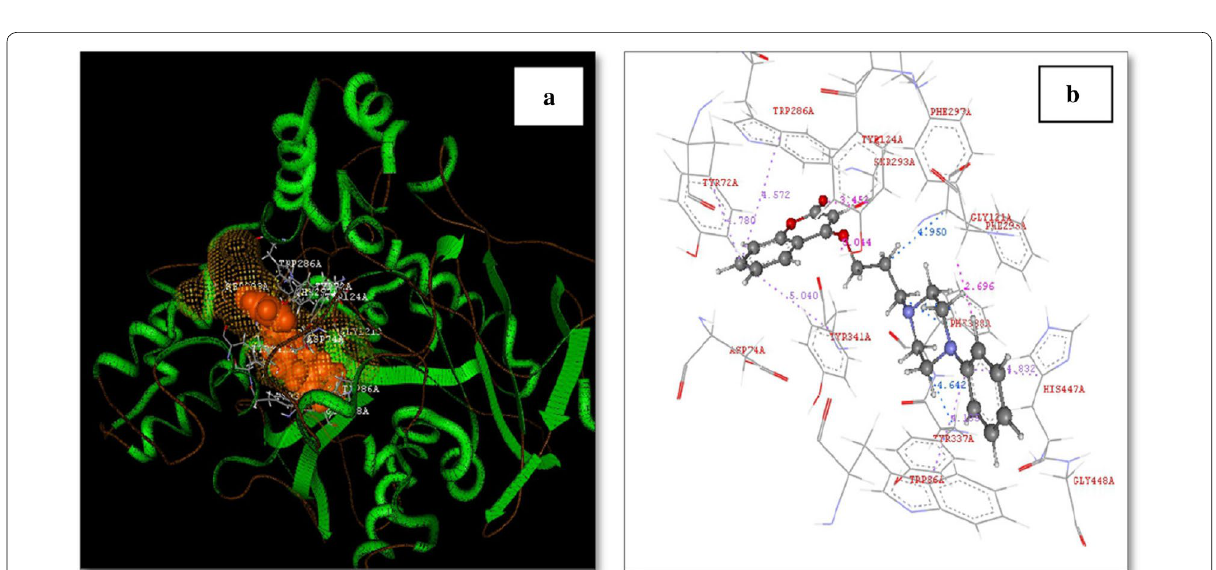
Fig. 11 a 3D Orientation of the best docked pose of compound C8 in the active site cavity of AChE. b Hypothetical binding motif of C8 within the crystal structure of AChE surrounding active amino acids